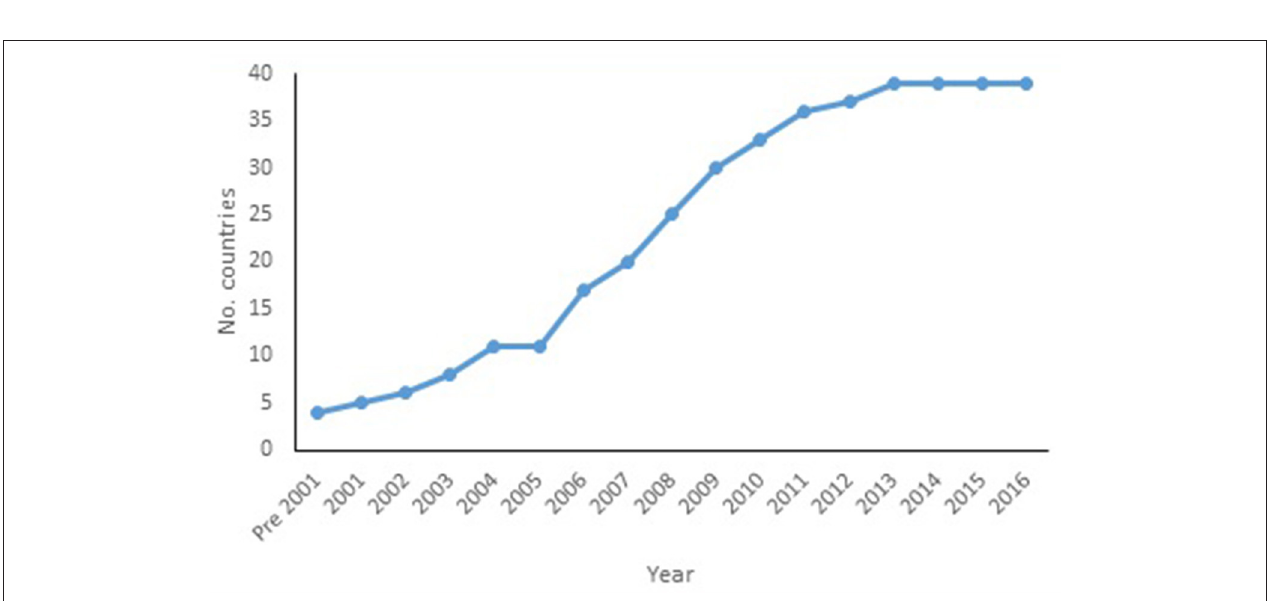
FIGURE 2 | Cumulative number of European countries with H. axyridis recorded as present. (Island territories included with their country, e.g., Corsica is included with France).